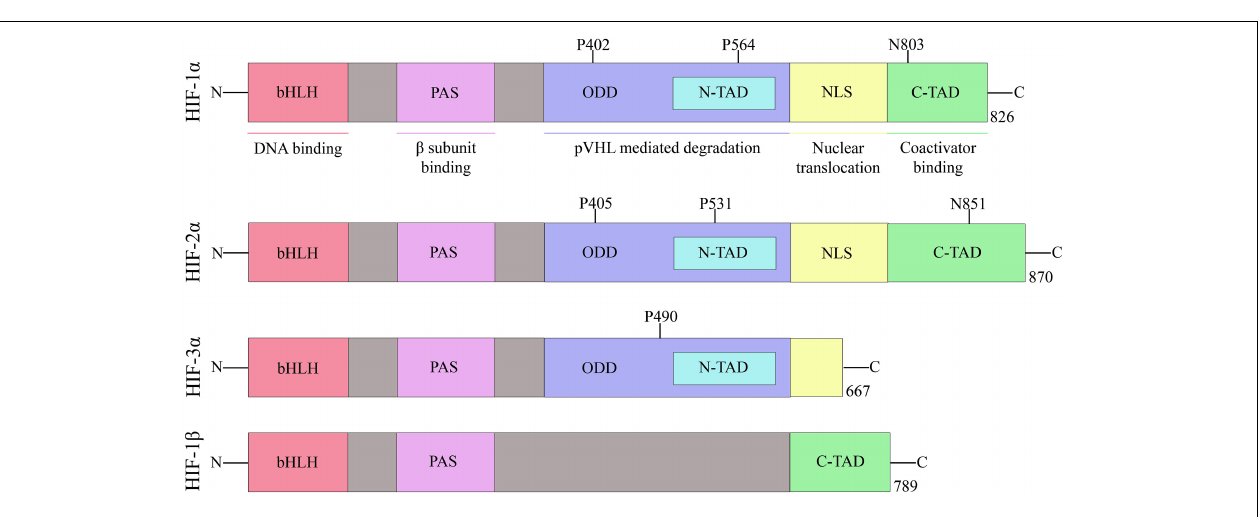
FIGURE 2 | Domain structure of human HIF subunits and